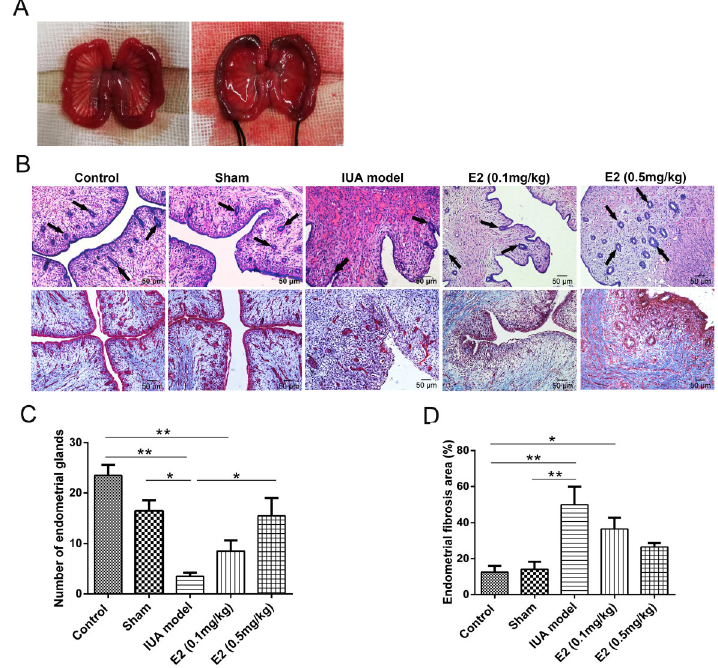
Figure 6. Relatively high doses of estrogen (E2) for the treatment of a rabbit intrauterine adhesion (IUA) model. A , Normal morphology of rabbit uterus (left) and of rabbit uterus damaged by mechanical injury and lipopolysaccharide infection (right). B , Endometrial morphology was observed by hematoxylin and eosin and Masson staining (magni fi cation 200 (cid:1) , scale bar 50 m m). C , Statistical comparison of endometrial glands in the visual fi eld of each group. D , Statistical results of endometrial fi brosis area in each group. Data are reported as means ± SD. *P o 0.05, **P o 0.01 (ANOVA).